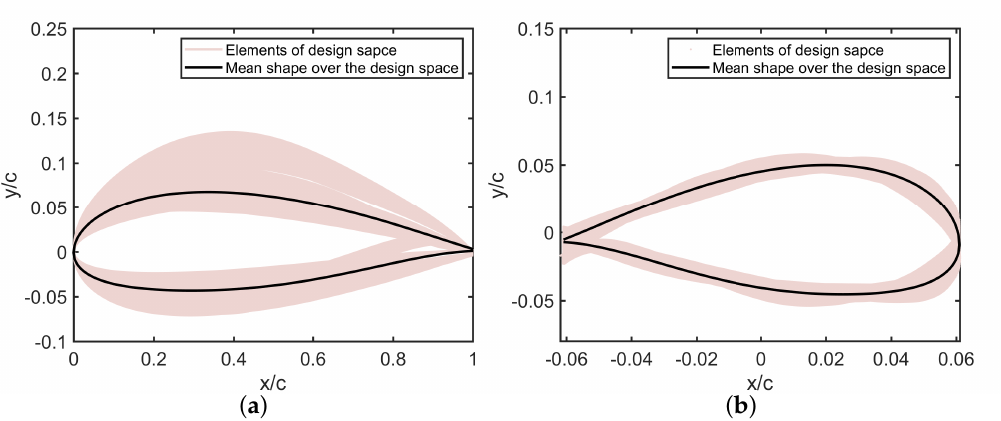
Figure 3. Mean shape and design space: ( a ) physical space; and ( b ) Grassmannian